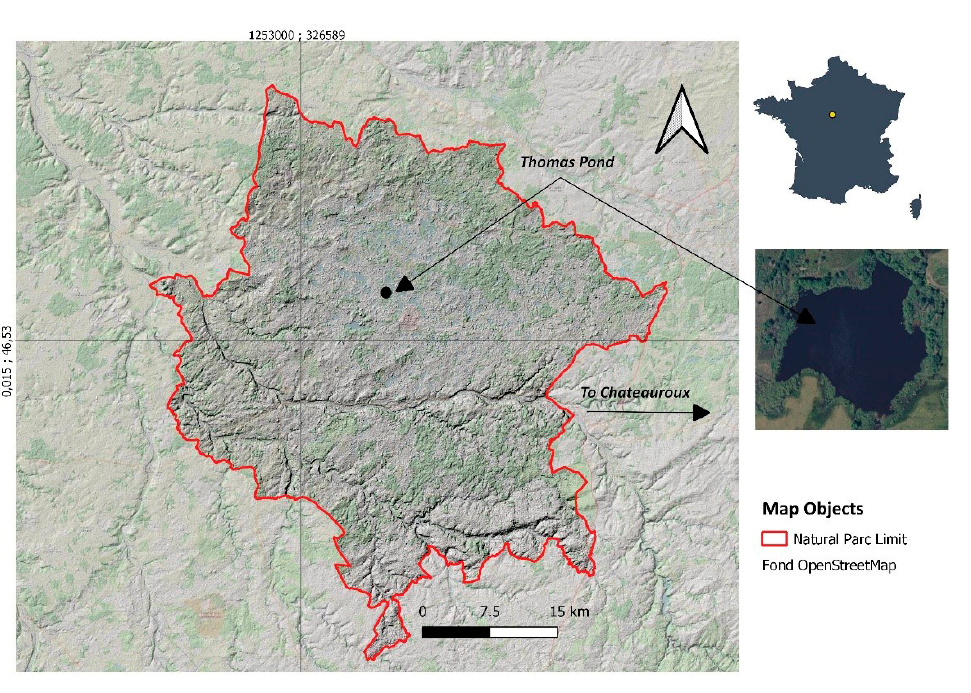
Figure 1. Location of the studied